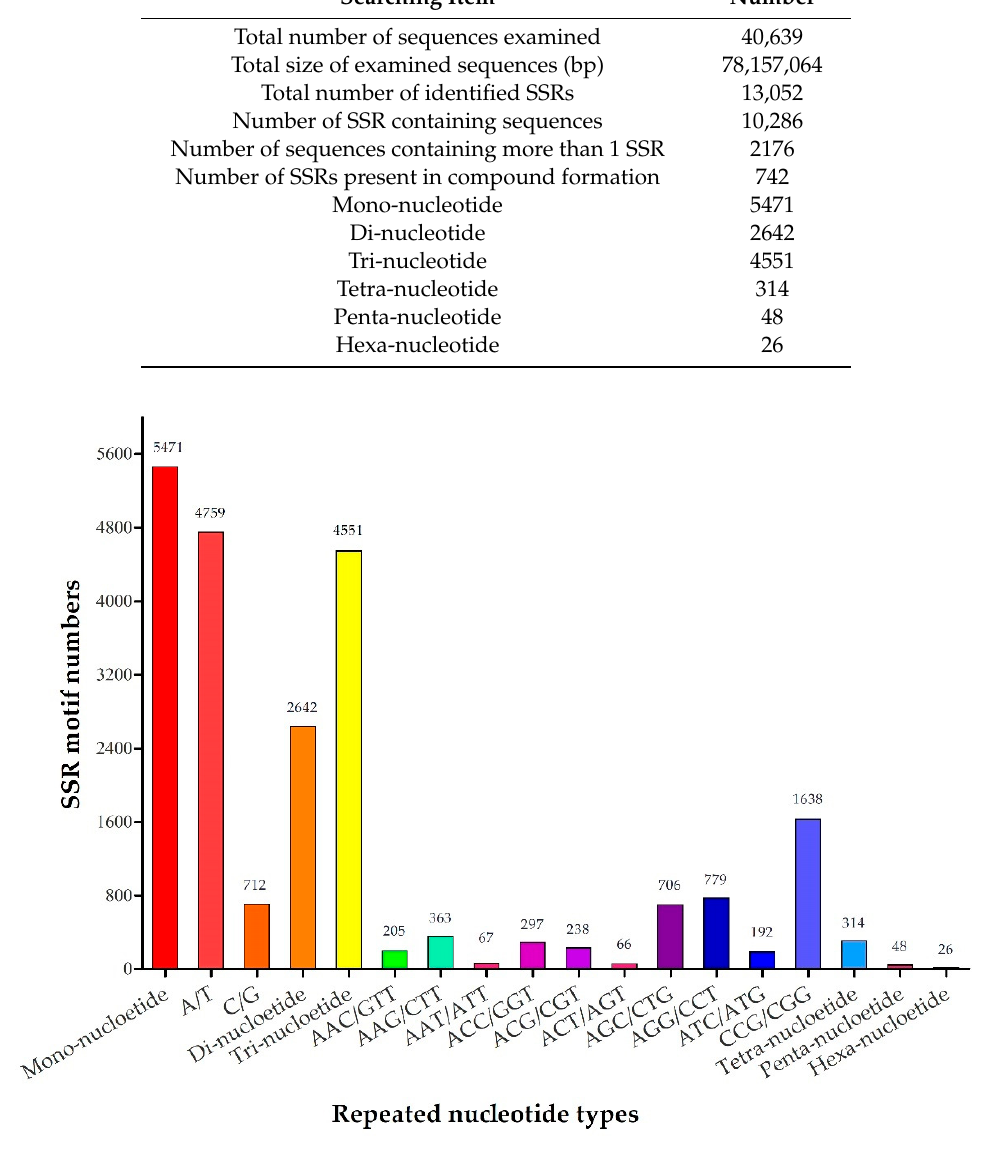
Figure 2. Di ff erent types of SSR repeats and their percentage based on Figure 2. Different types of SSR repeats and their percentage based on RNA-seq.